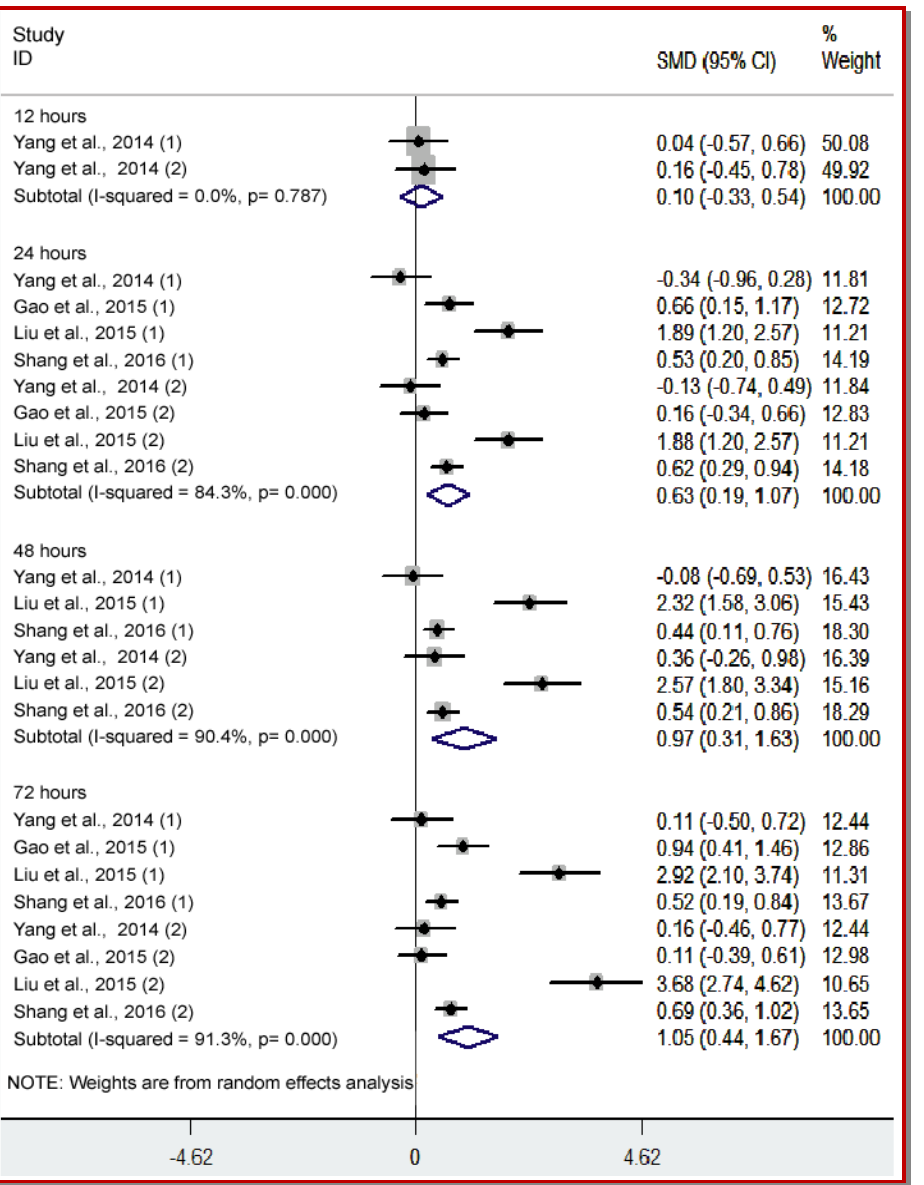
Figure 11: Meta-analysis of beta-blocker on the central venous blood oxygen saturation (digit within the parenthesis means the number of studies for